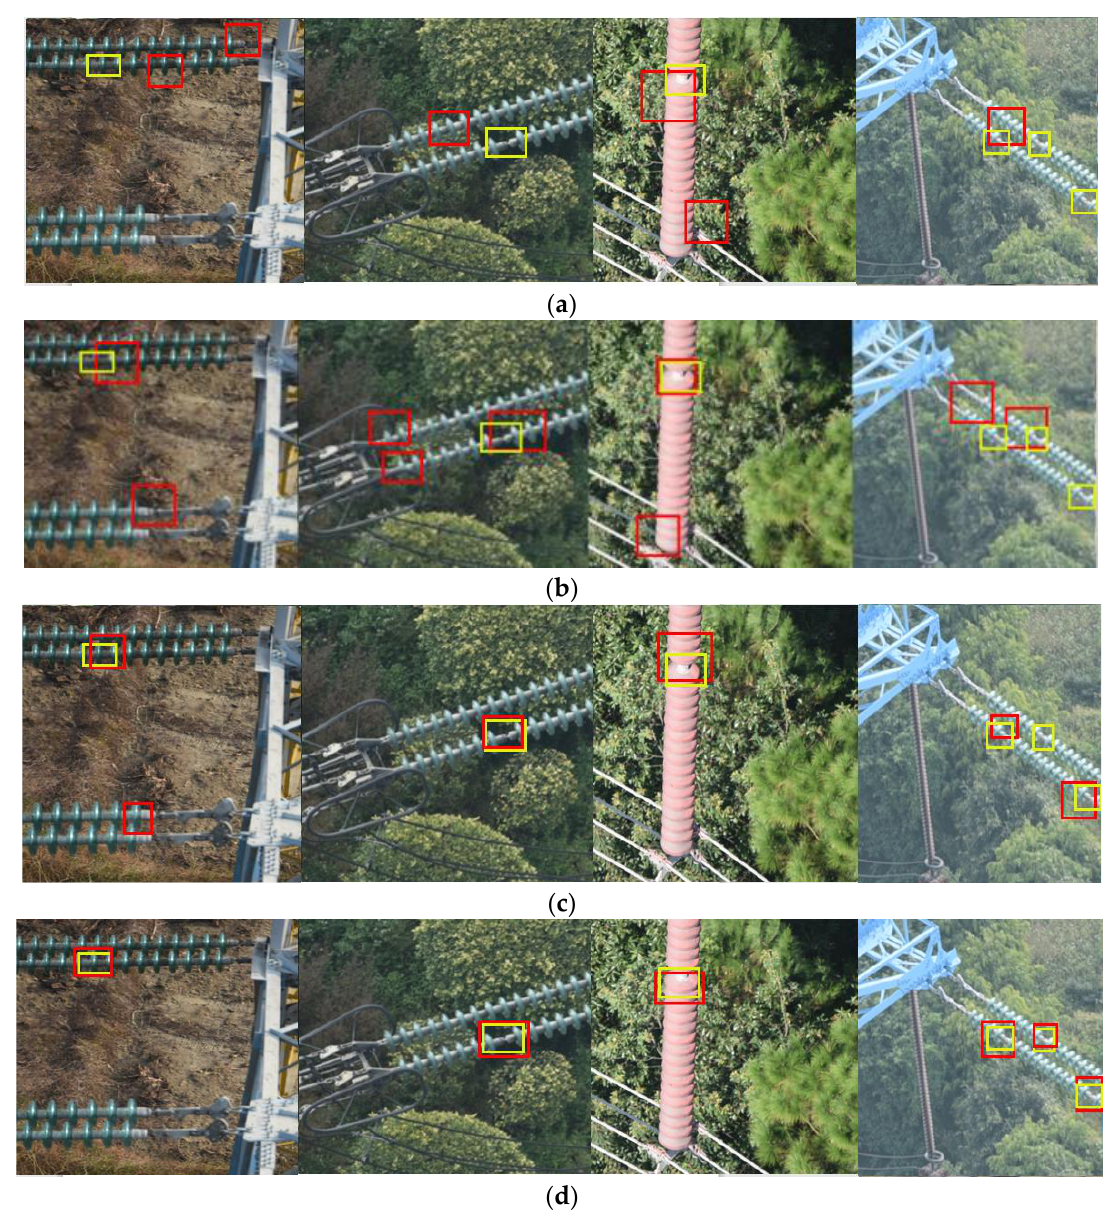
Figure 19. Mask examples mapped to the raw image after filtering under different backbones. ( a ) MobileNetV2. ( b ) ResNet.